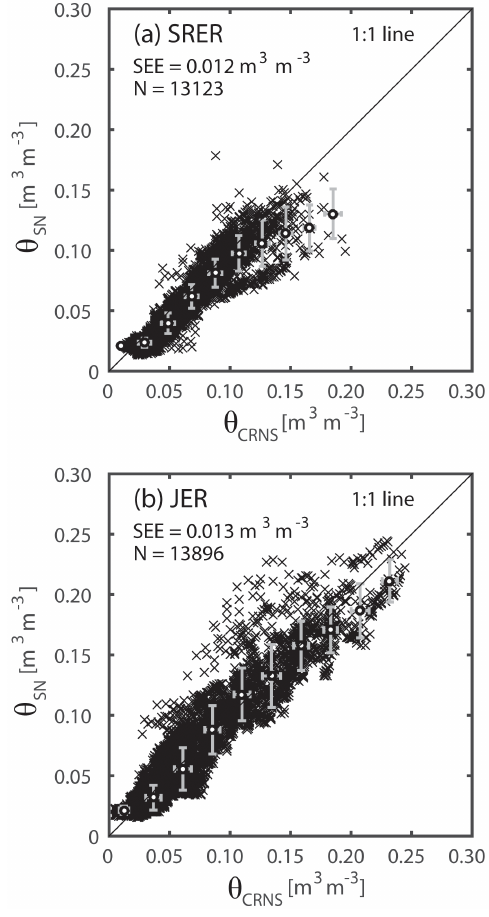
Figure 5. Scatter plots of the spatially averaged, hourly soil mois- ture (m 3 m − 3 ) from CRNS method ( θ CRNS ) and distributed sensor network ( θ SN ) at (a) SRER and (b) JER. The SEE and the number of hourly samples ( N ) are shown for each site. Bin averages and ± 1 standard deviation are shown (circles and error bars) for bin widths of 0.025m 3 m − 3